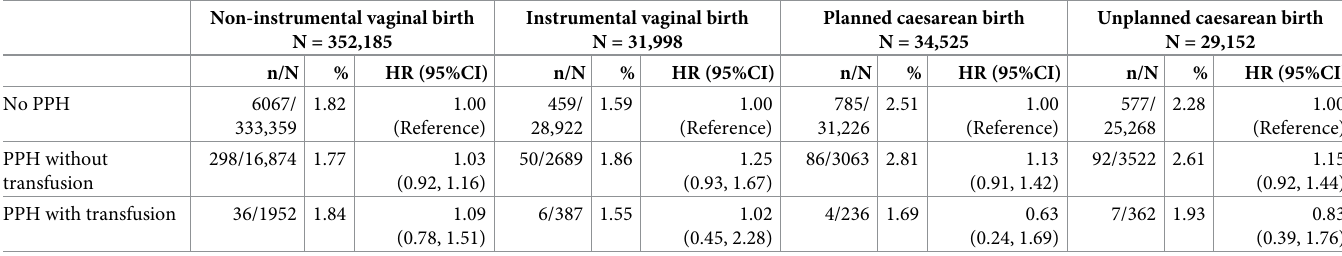
Adjusted for maternal age, family situation, education, parity, gestational age, birthweight, maternal smoking status, and early pregnancy maternal